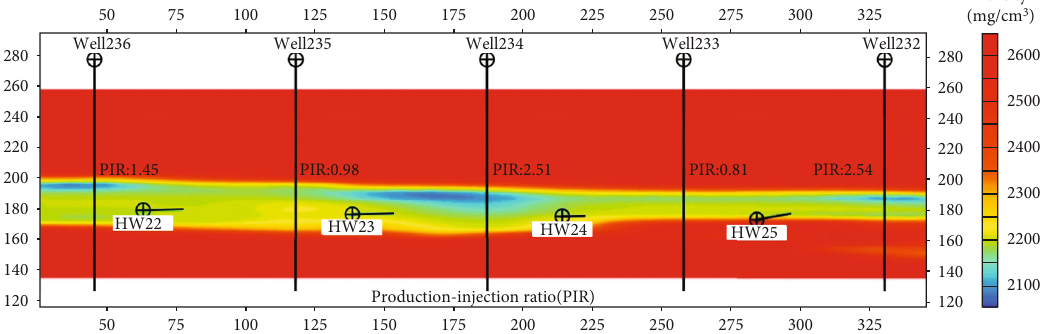
Figure 9: Comparison of production performance and well connectivity prediction results of well